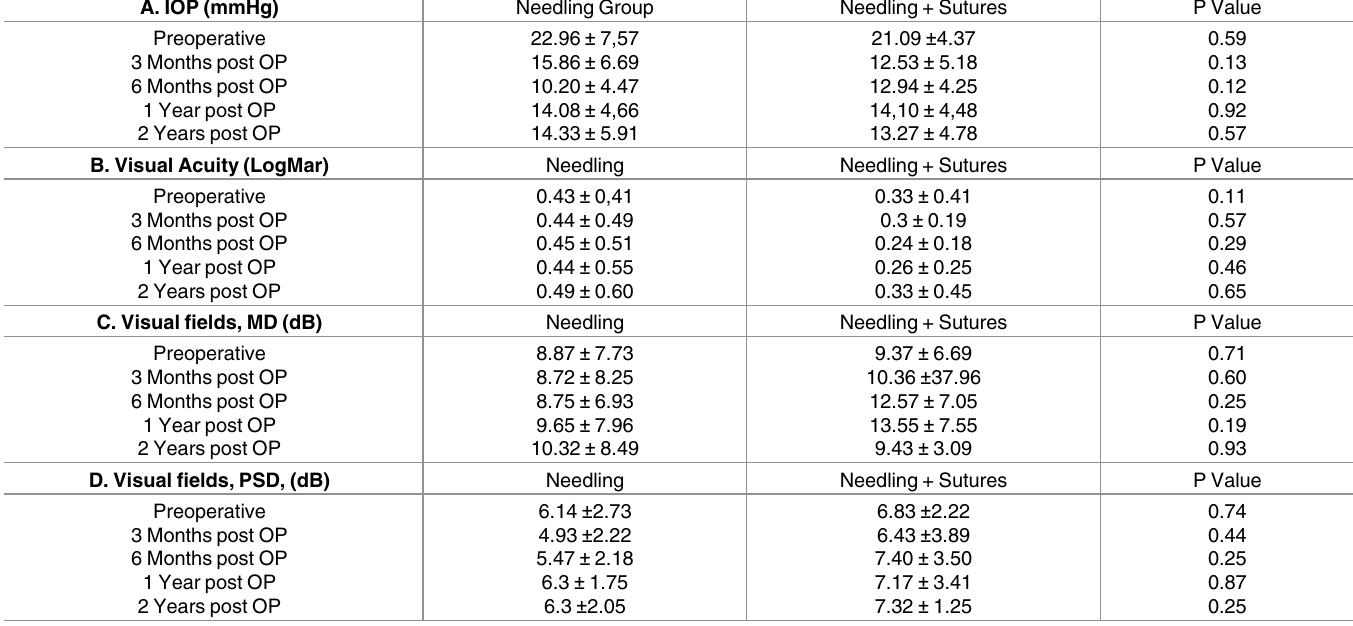
Table 1. Intraocular pressure (A), visual acuity (B), mean deviation (C) and pattern standard deviation (D) in the visual fields examination before bleb revision and at specific time points within the following two yearsin both study groups. Results are presentedas means with standard deviation. P values for the comparisonbetweenthe study groups are also